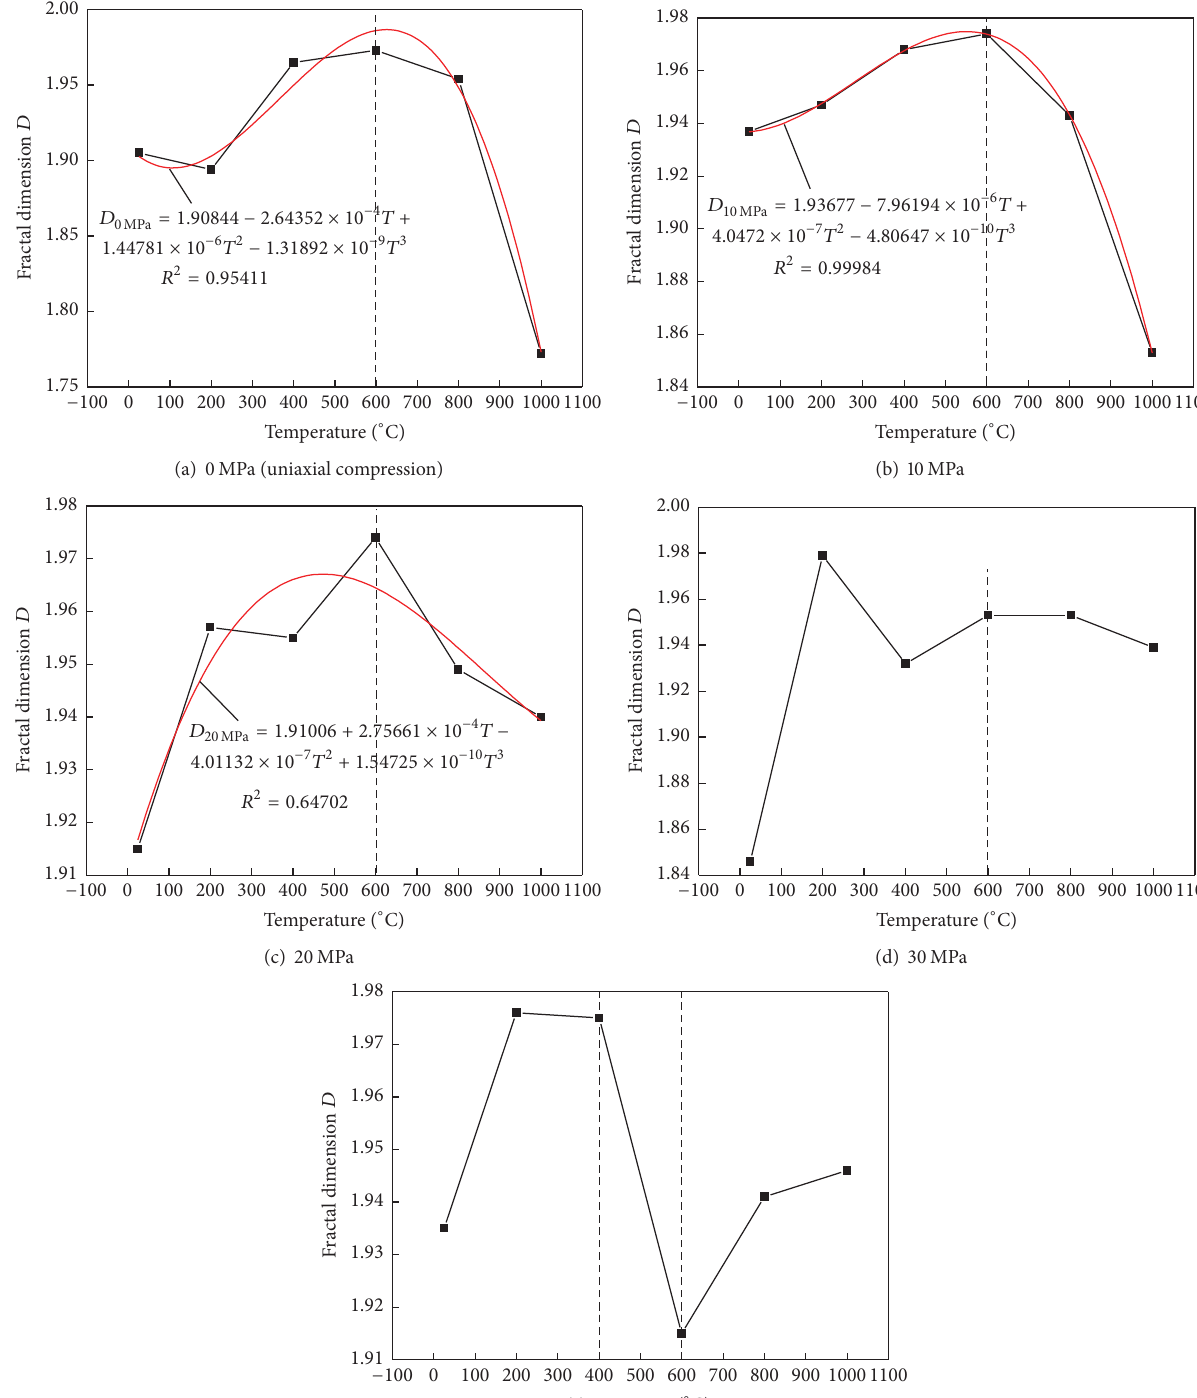
Figure 3: Relationship between fractal dimension and